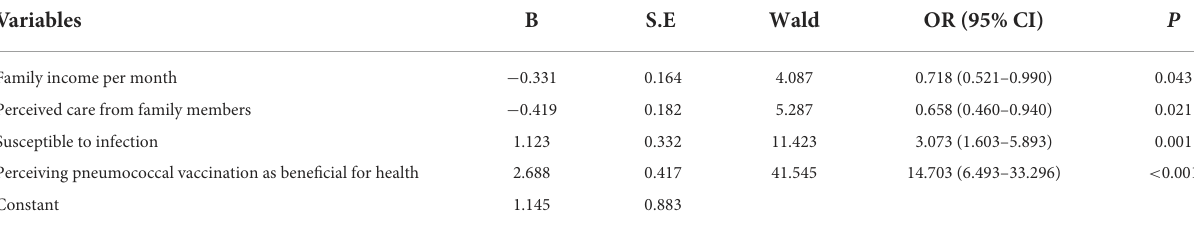
TABLE 6 Multivariate analysis of factors associated with willingness to get pneumococcal vaccination among SLE patients. Variables